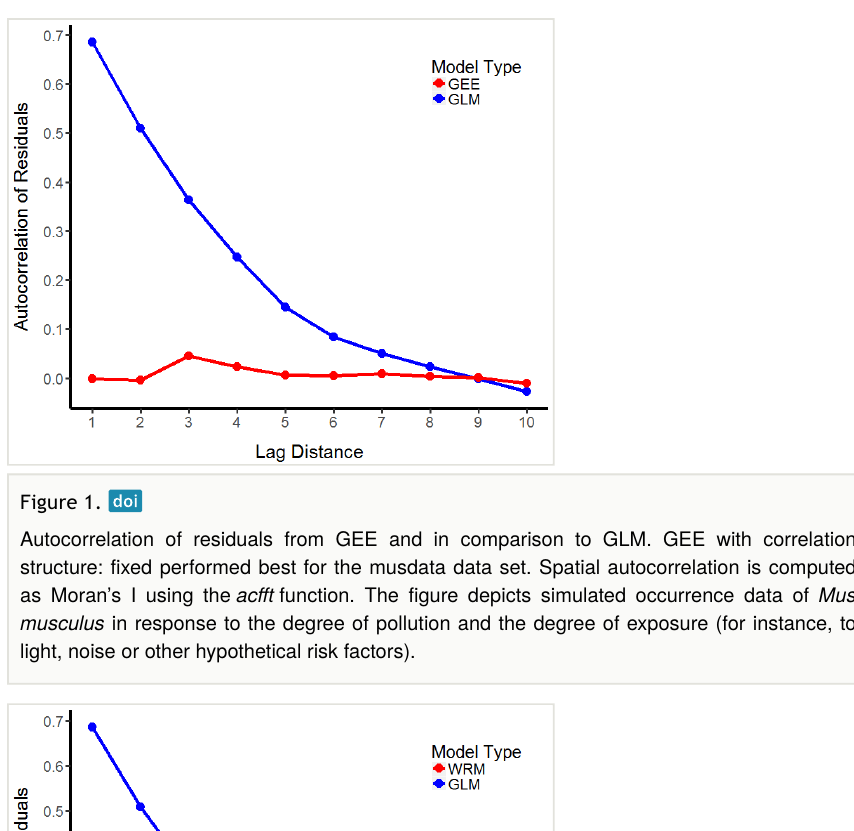
Therefore, there are di ff erent settings for padform in pad=list(…) . Moreover, there is a factor padzone in pad=list(…) for expanding the padding zone.